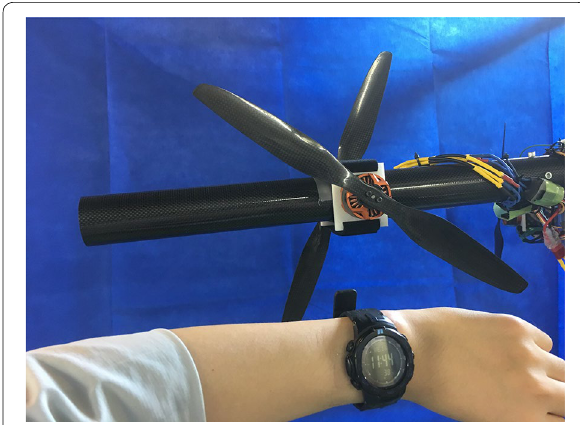
Fig. 1 A flying watch attached to one link of a robotic arm. A wristwatch is included in the figure to demonstrate the similarity between flying watch and wristwatch and the size of the flying